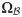
Illustration of an arterial network with nodes Ni, i = {0, … 3} and connecting edges.Each edge has an associated length Ljk, radius Rjk and medial axis (dashed lines). In the current example, N0, N2, N3 are terminal nodes, while N0 is also a root terminal mediating incoming fluid into the vascular network. Node N1 is an interior node. Brain tissue ΩB is shown as a filled ellipsoid, and arrowheads indicate direction of flow. For the sake of illustration, only the arterial network is shown, but a similar, fluid collecting venous network is also present in the model.